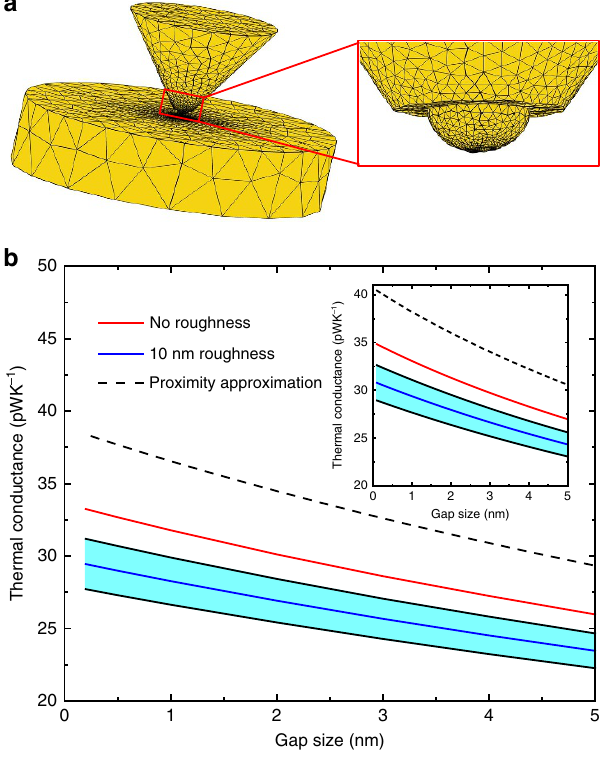
Figure 5 | Computational prediction of the radiative thermal conductance. ( a ) Tip-substrate geometry employed in our numerical simulations. Following the SEM images of our thermal probes, the tip was modelled as an irregular cone that ends in a hemisphere, while the substrate was modelled as a thick disk. The height of the cone was chosen to be 3 m m and the radius of its base was 1.9 m m. The radius of the disk was 4 m m and its thickness was 2 m m. The solid black lines depict the triangular mesh employed in the boundary element method (BEM) calculations. The right inset shows a blow-up of the tip apex region. ( b ) The computed total radiative thermal conductance as a function of the gap size between the Au tip and substrate. The red solid line corresponds to the ideal tip (no roughness) and the blue line to the average obtained for 15 different tips with stochastically chosen roughness profiles (RMS roughness B 2–3nm), while the shaded region indicate the s.d. The black dashed line is the computed thermal conductance from the proximity approximation for the case of no roughness. The tip diameter in these calculations is 300nm, while the temperature of the probe and substrate were chosen to be 303 and 343K, respectively. Inset, similar to the main panel except that the probe and substrate temperatures are 315 and 445K,